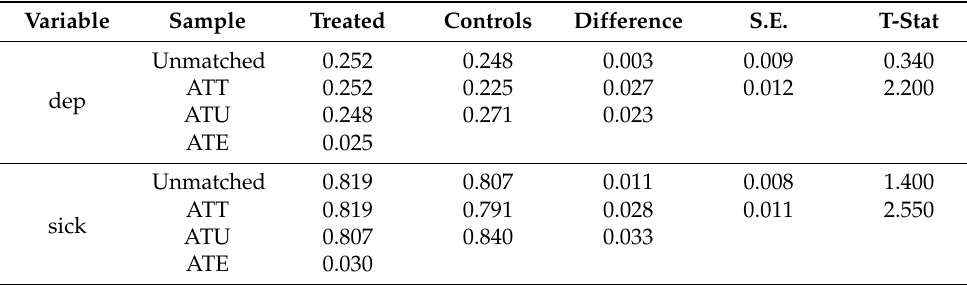
Table 8. Propensity Score Match Estimation